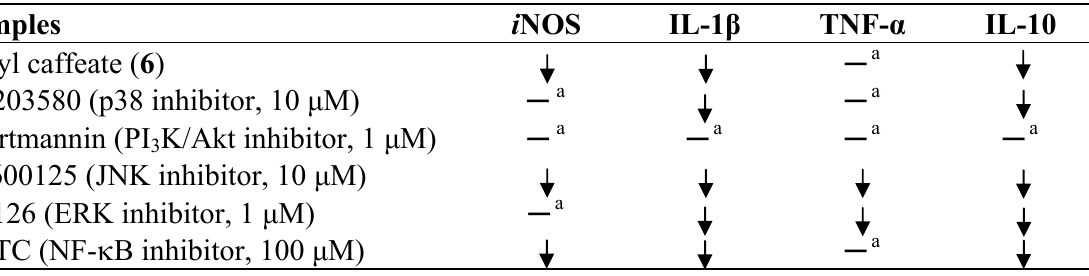
Table 2. Effects of compound 6 and five different blockers on LPS-induced i NOS, IL-1 β , TNF- α , IL-10 mRNA expression in RAW264.7